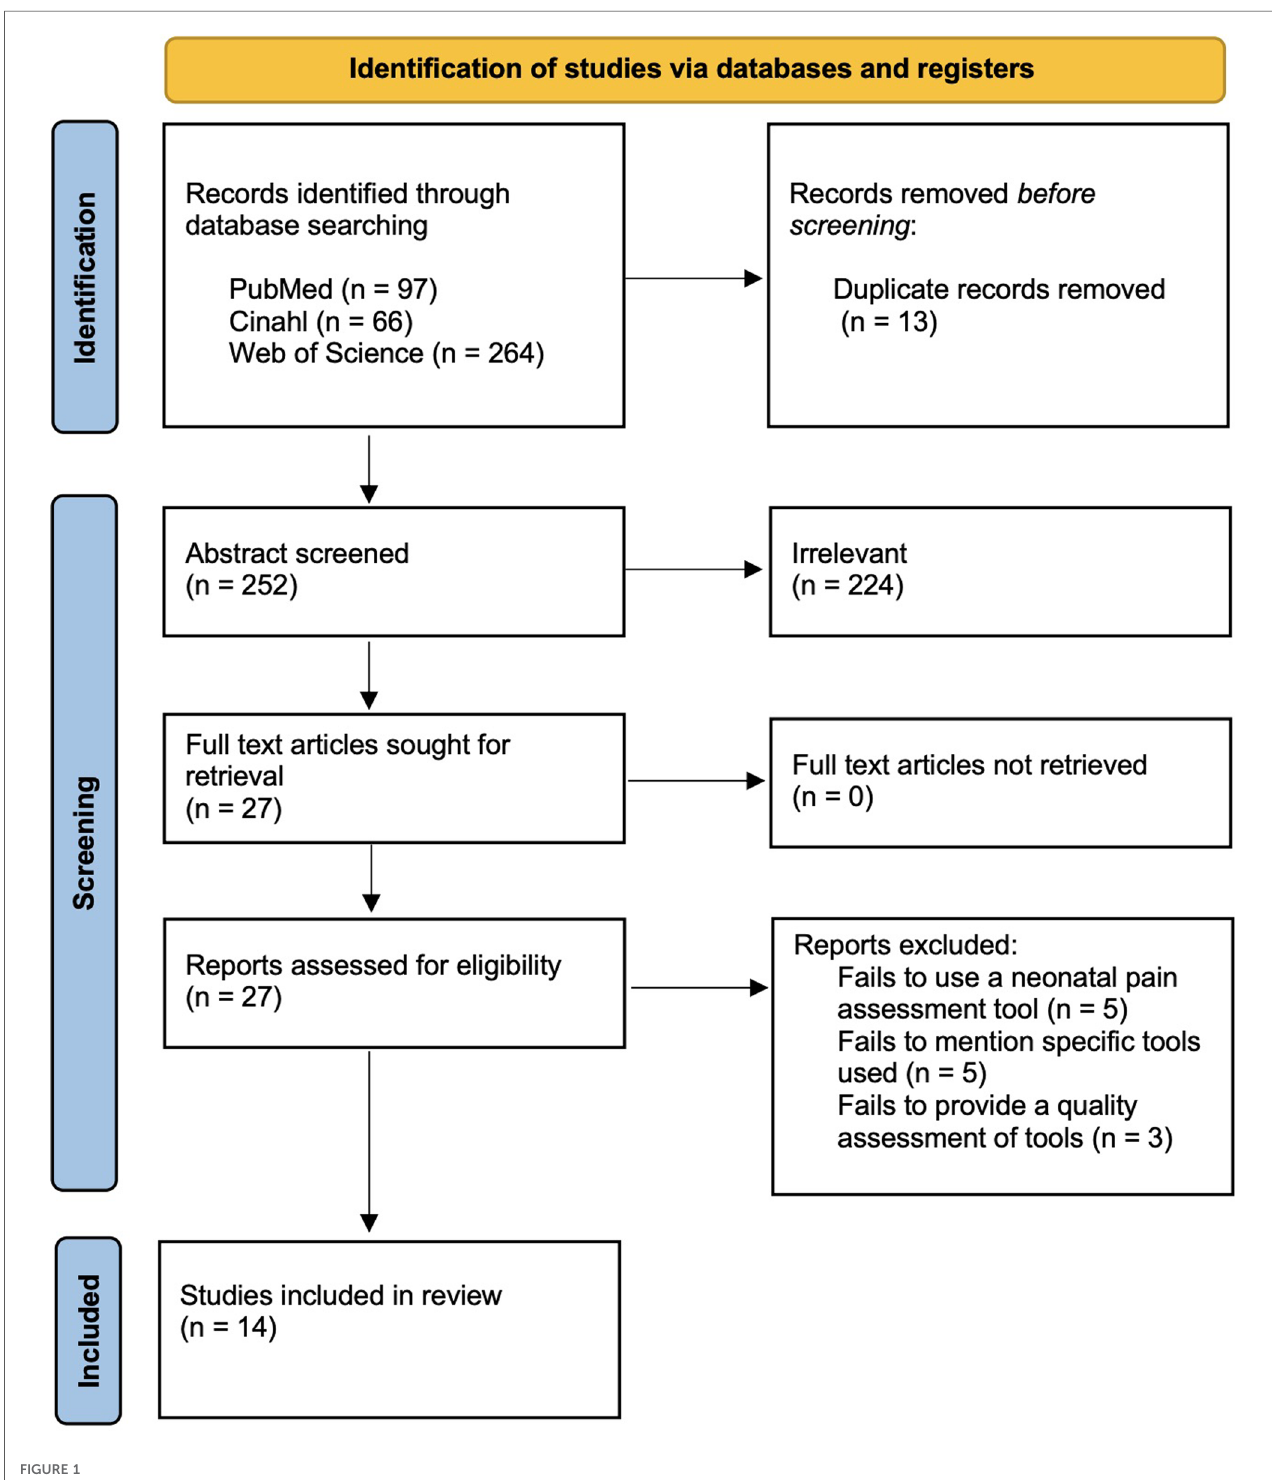
FIGURE 1 PRISMA fl ow